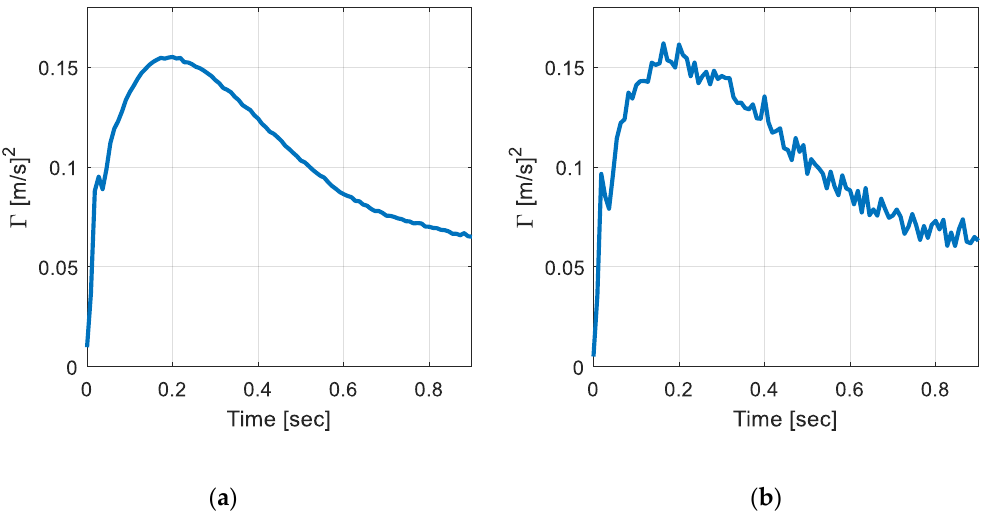
Figure 6. Covariance response with measured noise ( a ) SNR of 45 dB; and ( b ) SNR of 25 dB.